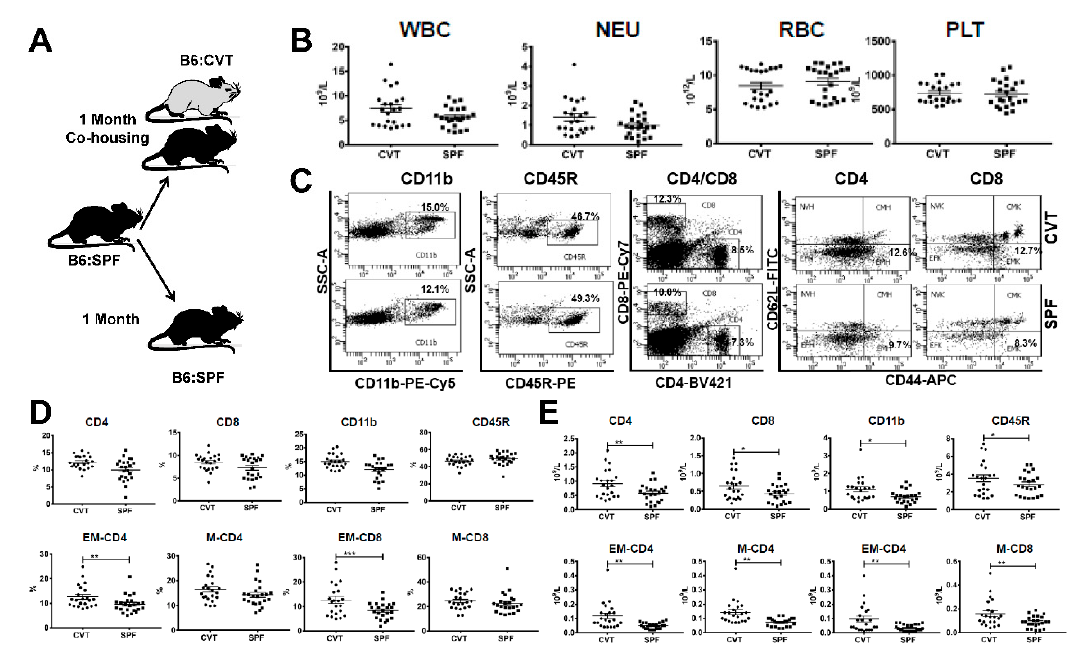
Figure 1. ( A ) C57BL/6J (B6) mice born and raised in specific-pathogen-free (SPF) conditions were either maintained in SPF or transferred to a conventional facility and co-housed (CVT) with mice born and raised in that facility for one month. ( B ) CVT (n = 22) and SPF (n = 23) mice were bled at one month of co-housing to analyze concentrations of white blood cells (WBC), neutrophils (NEU), red blood cells (RBC) and platelets (PLT). ( C ) Blood leukocytes were stained with specific antibodies and were analyzed by flow cytometry for the proportions of myeloid cells (CD11b), B cells (CD45R), helper T cells (CD4), and cytotoxic T cells (CD8), while CD4 and CD8 T cells were further divided, based on expression of CD62L and CD44, into naive (NV, CD44 − CD62L + ), central memory (CM, CD44 + CD62L + ), effector (EF, CD44 − CD62L − ) and effector memory (EM, CD44 + CD62L − ) subsets, all shown as representative dot plots. ( D ) Proportions of CD4, CD8, CD11b, CD45R, EM-CD4, M-CD4 (memory CD4, combined CM-CD4 and EM-CD4), EM-CD8 and M-CD8 (memory CD8, combined CM-CD8 and EM-CD8) cells in peripheral blood of CVT and SPF mice. ( E ) Calculated concentrations of CD4, CD8, CD11b, CD45R, EM-CD4, M-CD4, EM-CD8 and M-CD8 cells in peripheral blood of CVT and SPF mice. Data were combined from two experiments performed at different times. * p < 0.05; ** p < 0.01; *** p < 0.001.